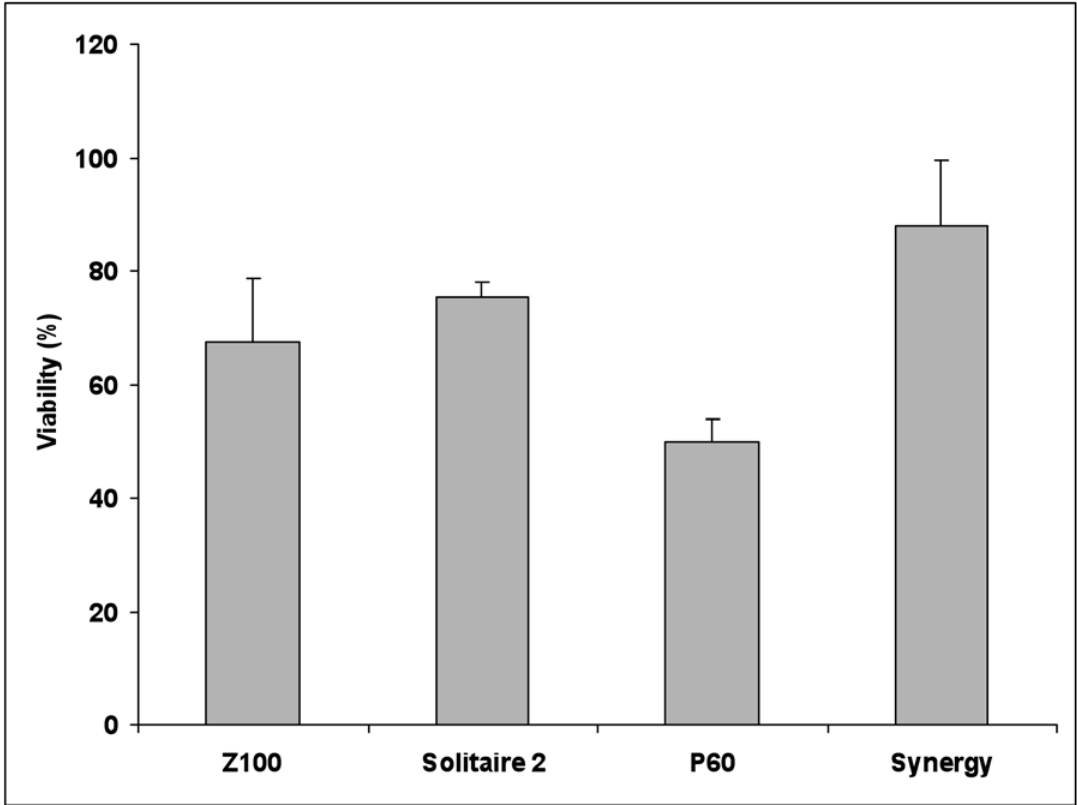
FIGURE 1- Percentage of viable brine shrimp larvae (Mean ± SD) exposed to the ethanolic extracts of the composite resins investigated in this study (brine shrimp assay)